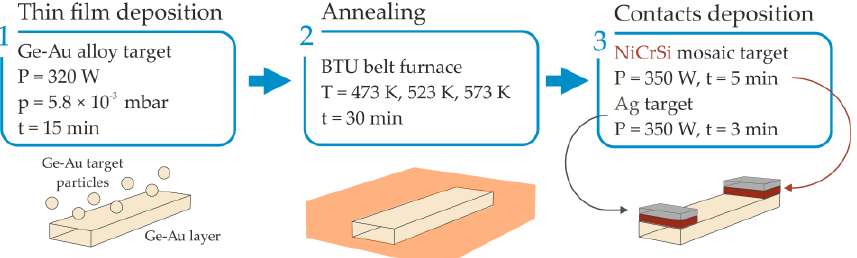
Figure 1. The Ge–Au/NiCrSi/Ag thermocouple fabrication process: ( 1 ) thin film deposition using the magnetron sputtering; ( 2 ) thin film post-process annealing; ( 3 ) the NiCrSi/Ag contact pad’s deposition using magnetron sputtering.